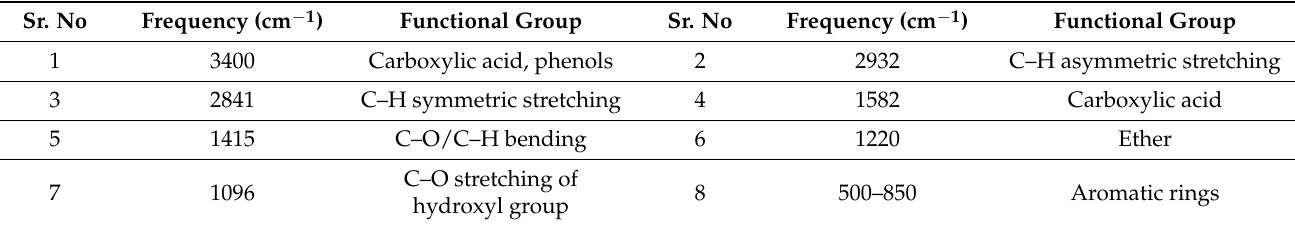
Figure 4. FTIR spectrum of synthesized silver nanocomposites. Table 4. Summary of the FTIR analysis of silver nanocomposites.